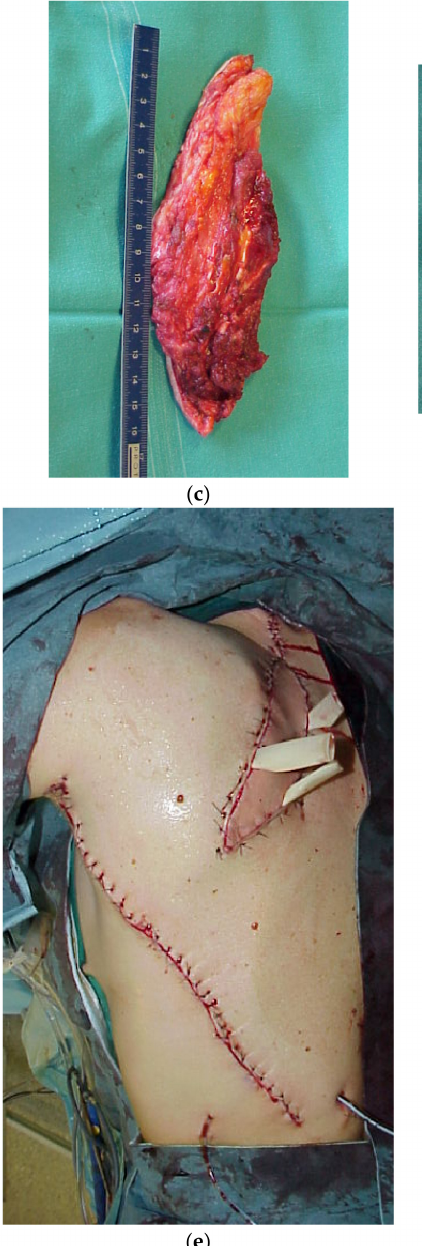
Figure 2. ( a ) Recurrence of fibrosarcoma in the scapular region; ( b ) the oncological excision exposes the scapula, ( c ) the tumor has been excised and ( d , e ) a pedicled myocutaneous latissimus dorsi flap has been used to cover the full thickness of the